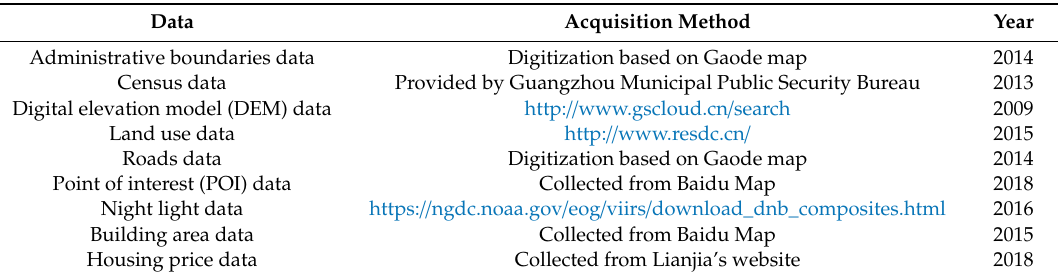
Table 1. Data Source Information.